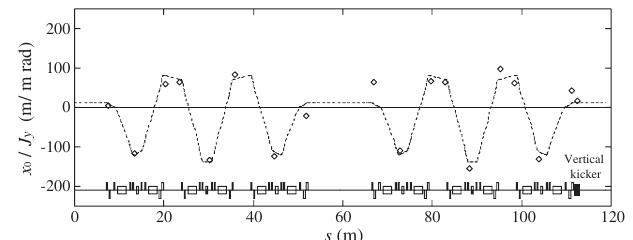
FIG. 3. Vertical amplitude dependent orbit shift. The diamonds are the measured shift at the BPMs and the broken line is the calculated shift using the analytical formula, Eq. (9). One extra data point at the long straight section ( s ¼ 113 m) was obtained by a newly installed BPM with the new vertical kicker magnet.